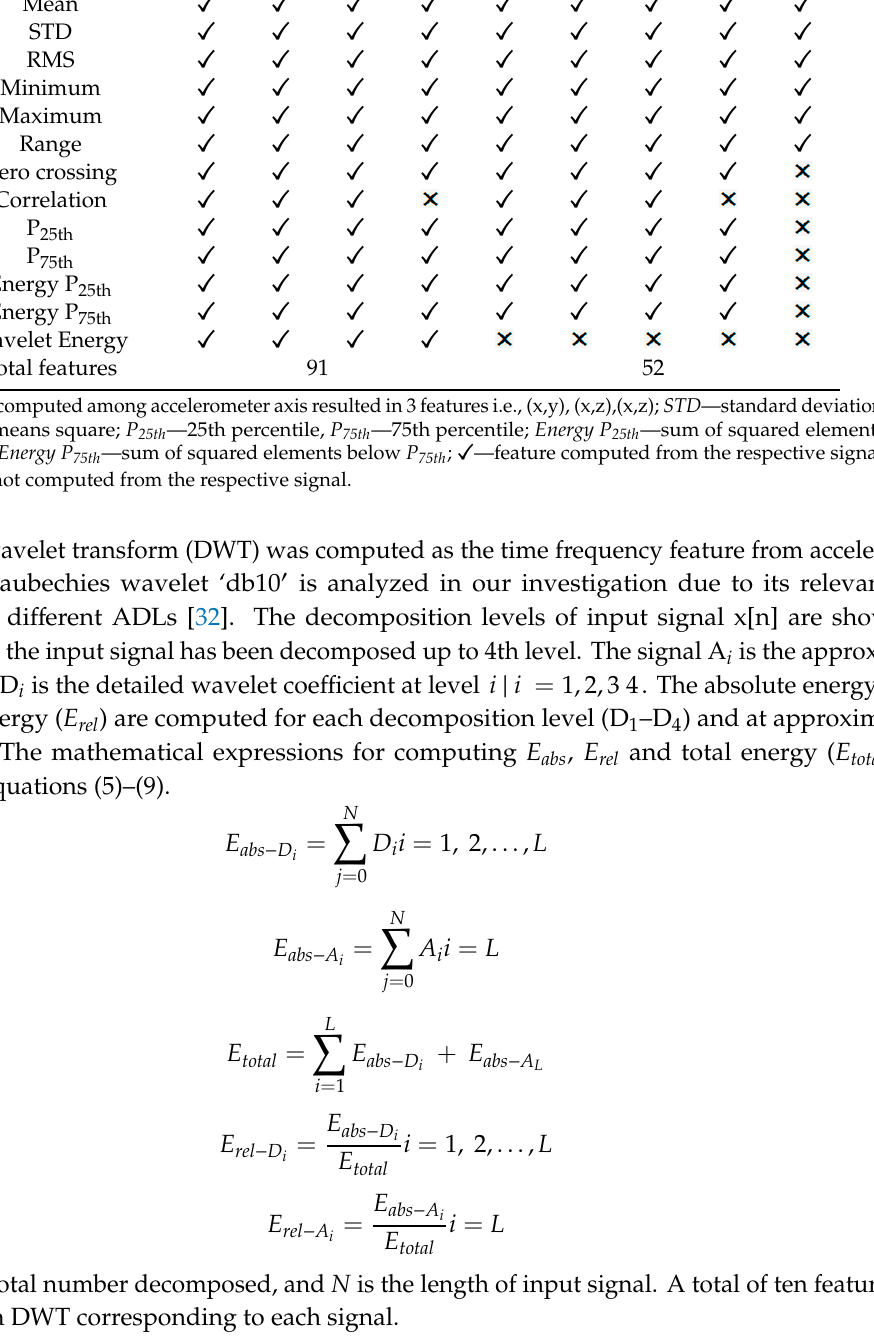
Table 2. Features computed from di ff erent signals and datasets. Smartphone Feature